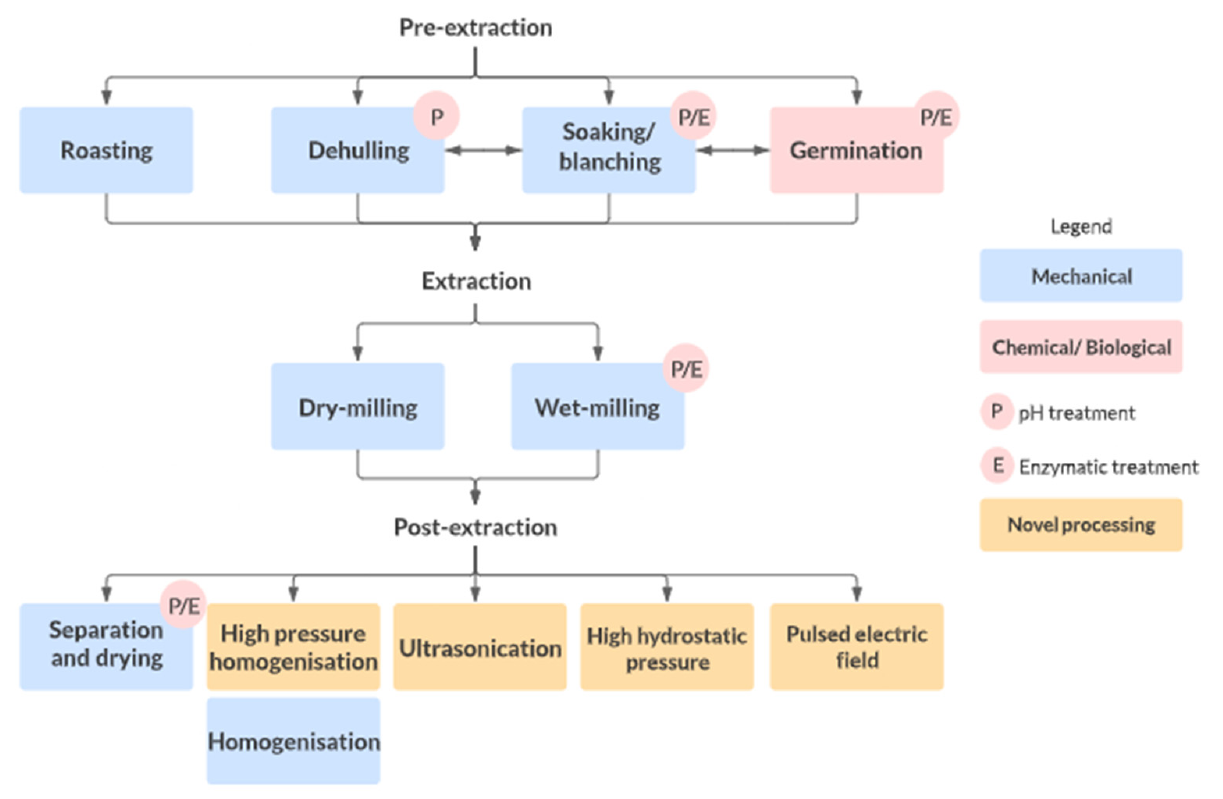
Figure 1. Overview of possible processing techniques for plant-based ingredient extraction for dairy analogue production.